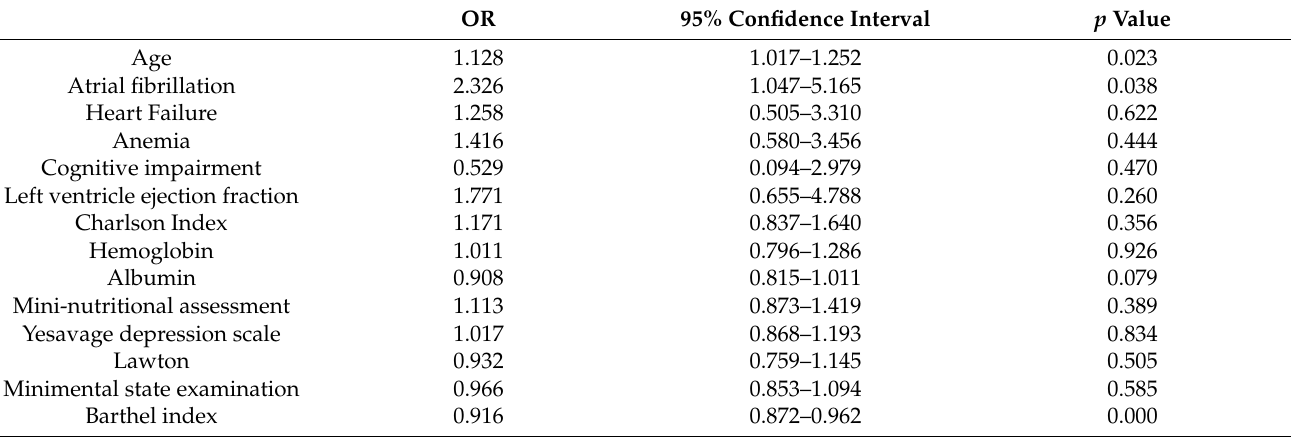
Table 2. Multivariable logistic regression.